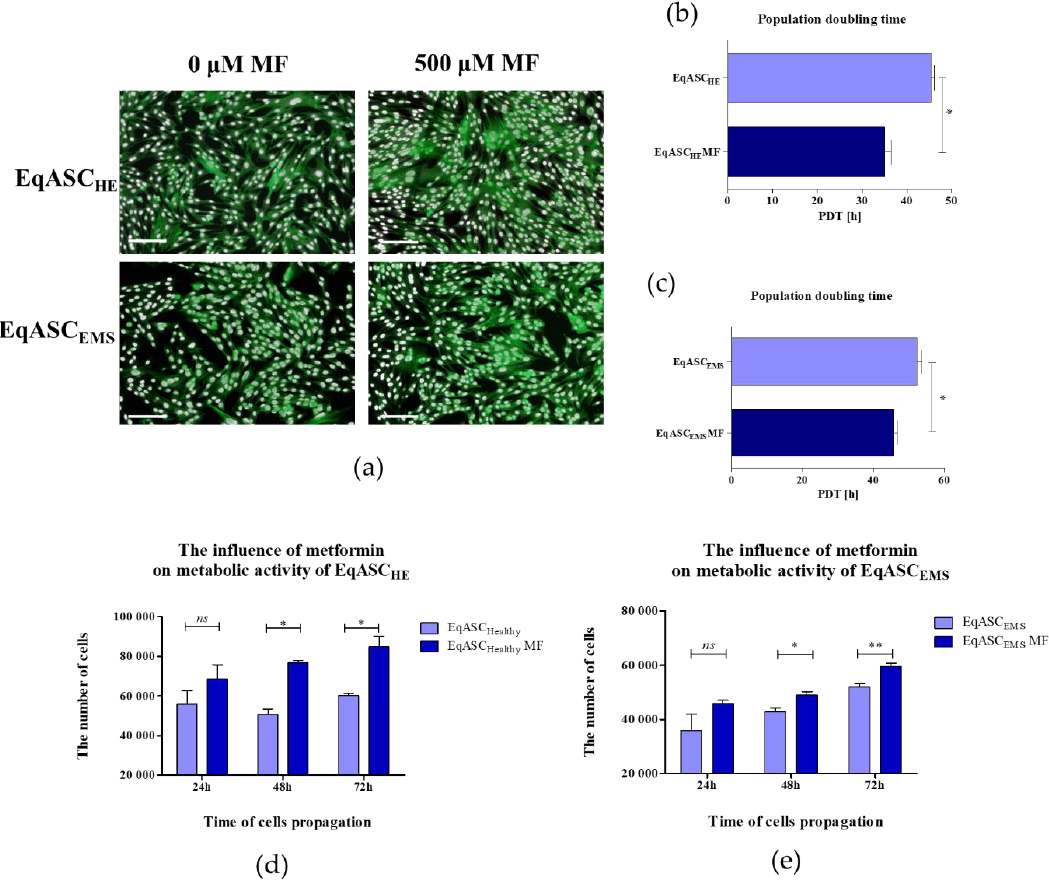
Figure 1. The influence of metformin on proliferative and metabolic activity of adipose-derived stromal cells isolated from horses (EqASCs). The proliferative activity was evaluated based on microphotographs obtained with epifluorescence microscope—scale bar 250 µ m ( a ) population doubling time ratio ( b , c ) and metabolic activity ( d , e ). The statistically significant changes were indicated with asterisks; * p < 0.05; ** p < 0.01, while non-significant differences are marked as ns .